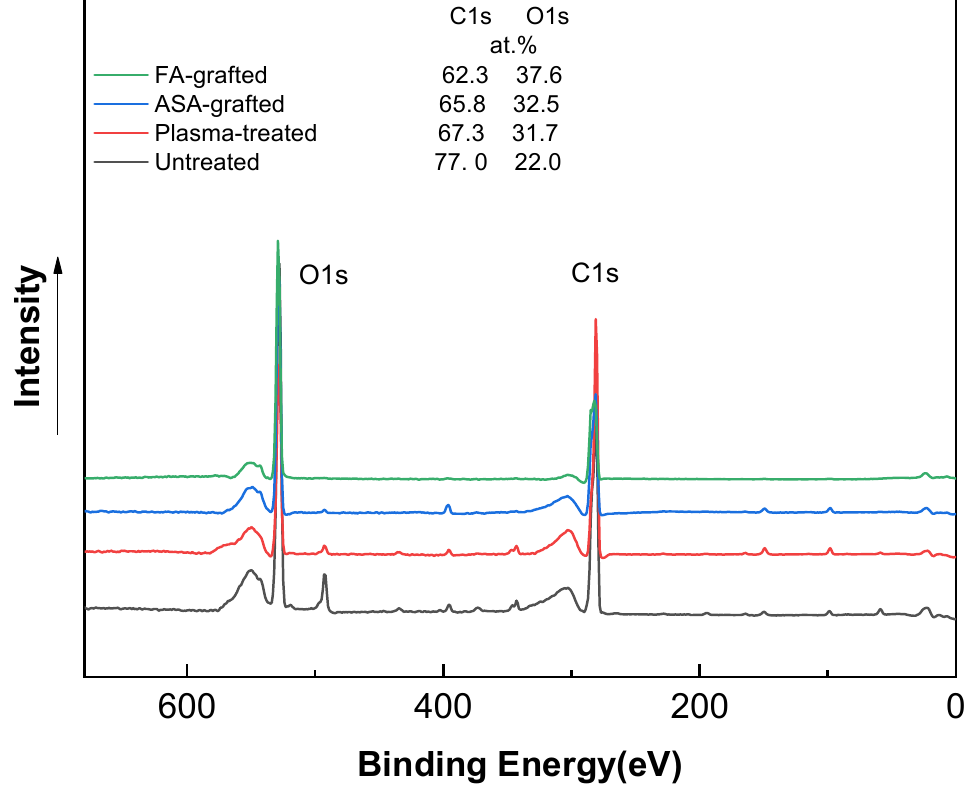
Figure 4. X-ray photoelectron spectroscopy (XPS) spectra of PLA samples.